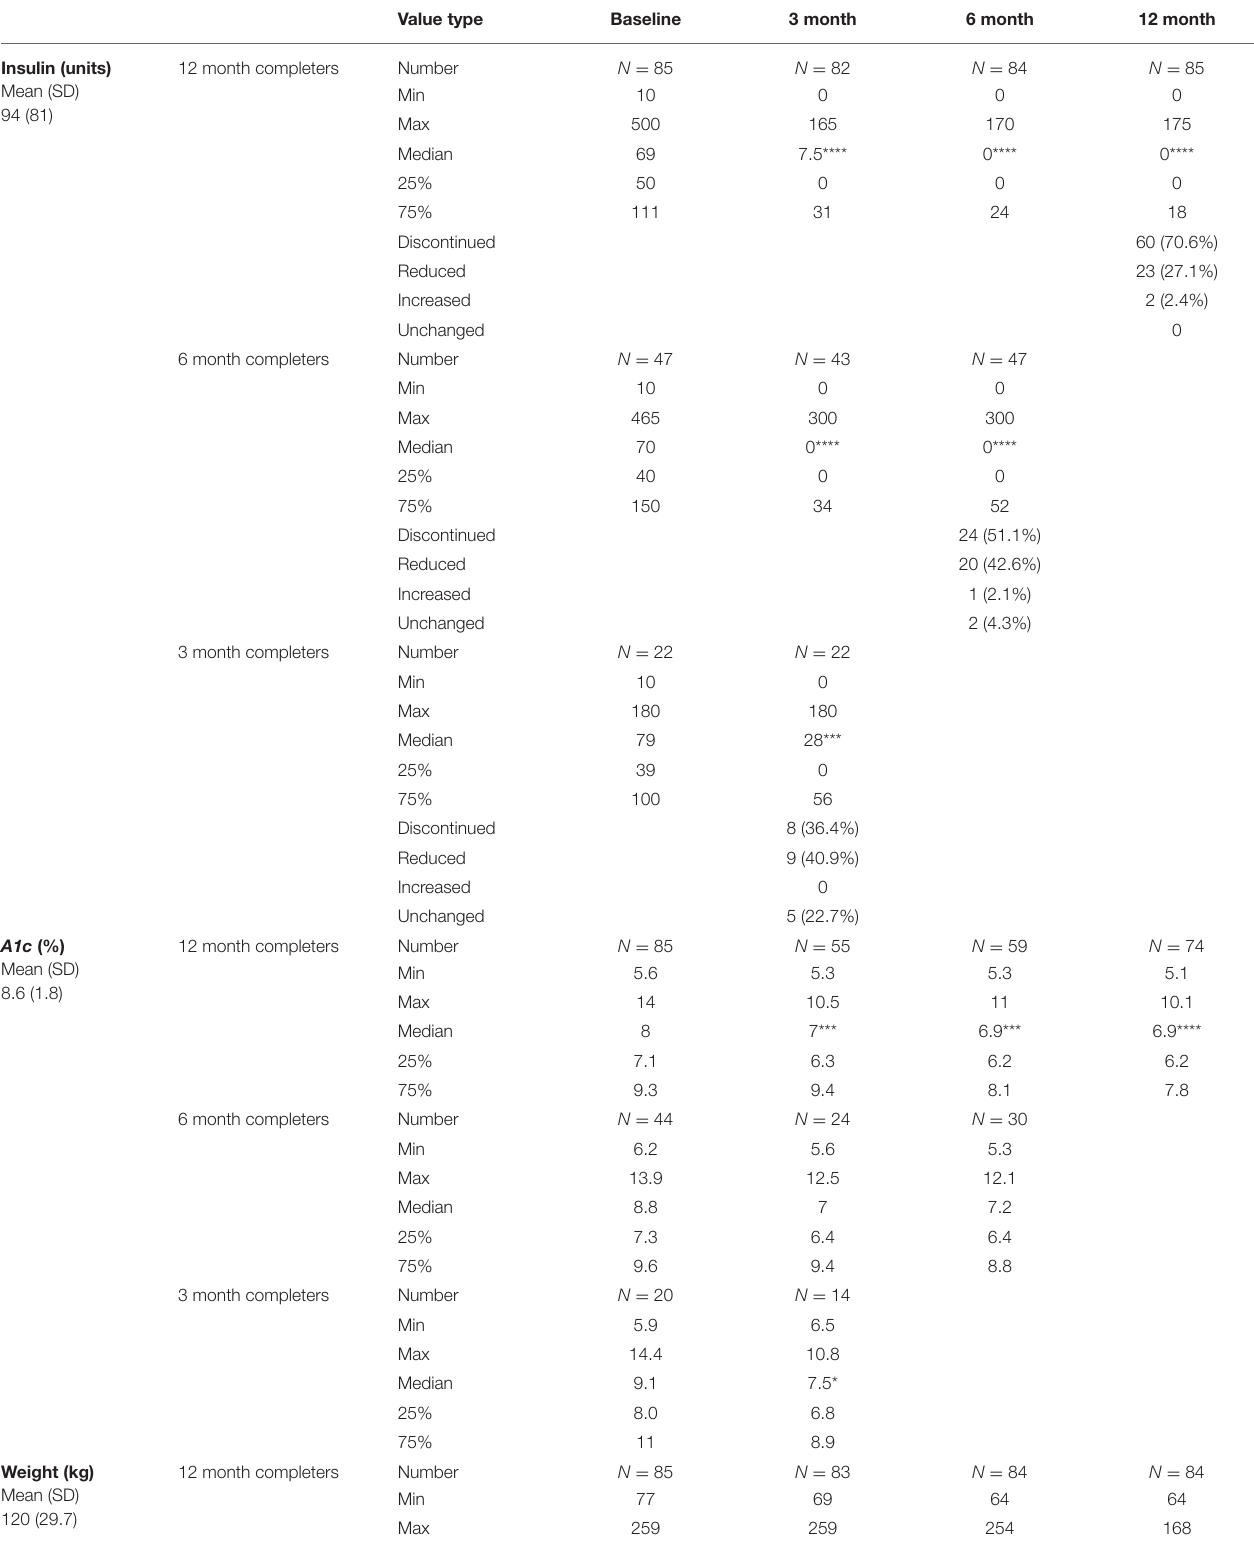
TABLE 2 | Weight, HbA1c, and insulin changes during study period for